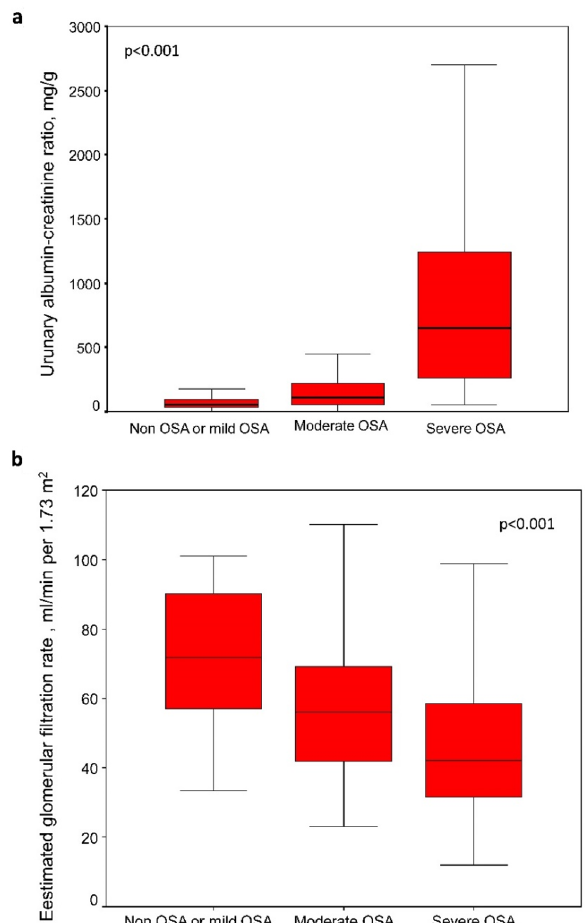
Figure 1. Box-and-whisker plots depicting the distribution of ( a ) urinary albumin–creatinine ratio and ( b ) estimated glomerular filtration rate of patients with diabetic kidney disease according to OSA severity. The dark line in the middle of the boxes represents the median and the length of the box reflects the interquartile range (IQR). The T-bars represent maximum and minimum values. Comparisons performed using SPSS 26.0 software (SPSS Inc., Chicago, IL, USA).